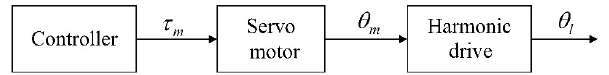
Figure 2. Servo Motor-Harmonic Drive Serial System. θ m is the rotation angle of the motor rotor, θ l the rotation angle on the output port of the harmonic drive, and τ m the output torque of servo motor.